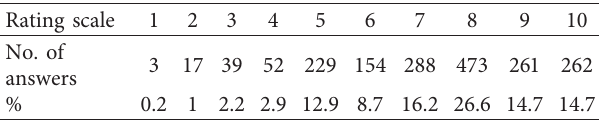
Table 9: IGSE administrators’ view on overall impact of modern gadgets on IGSE management quality. No. of